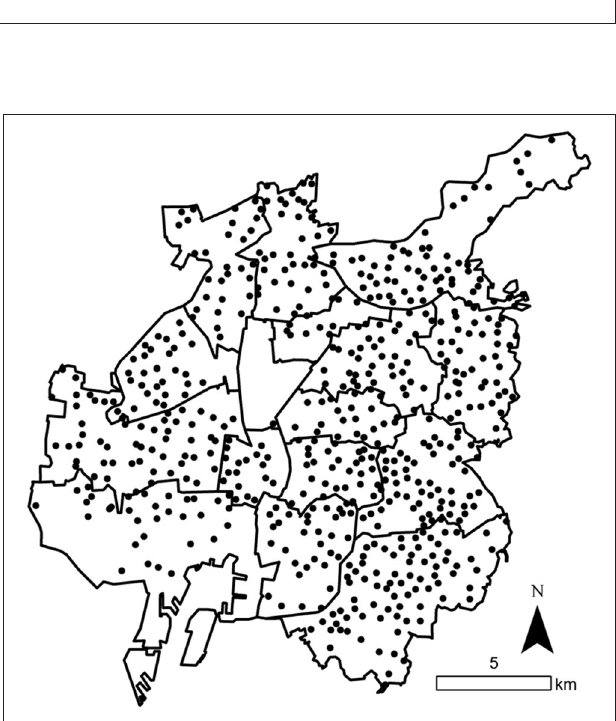
FIGURE 2 | Timeline of events.